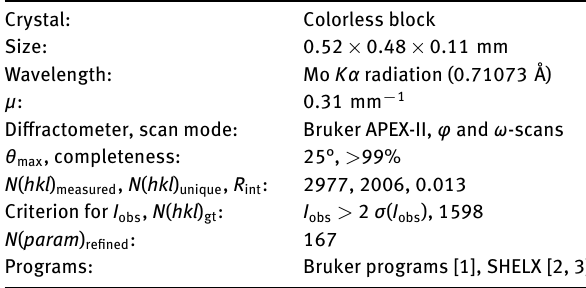
Table 1: Data collection and handling.